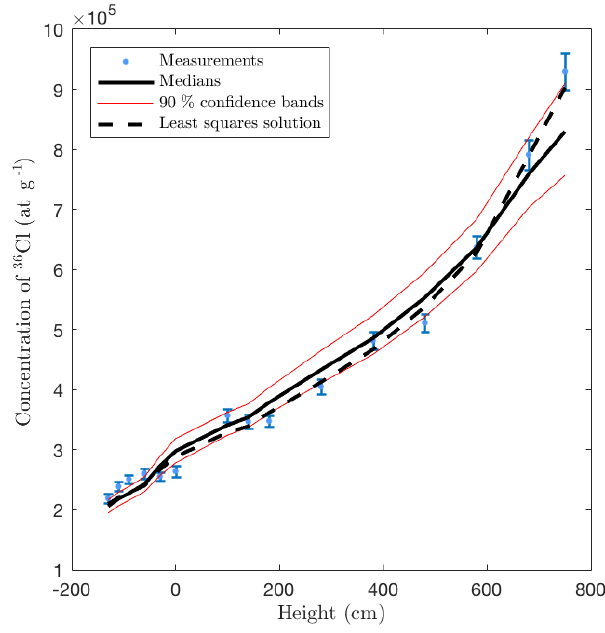
Figure 13. Frattura fault: measured and sampled 36 Cl concentra-